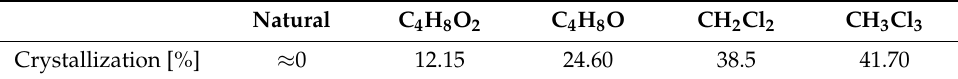
Table 5. Approximate percentage of crystallized sample.